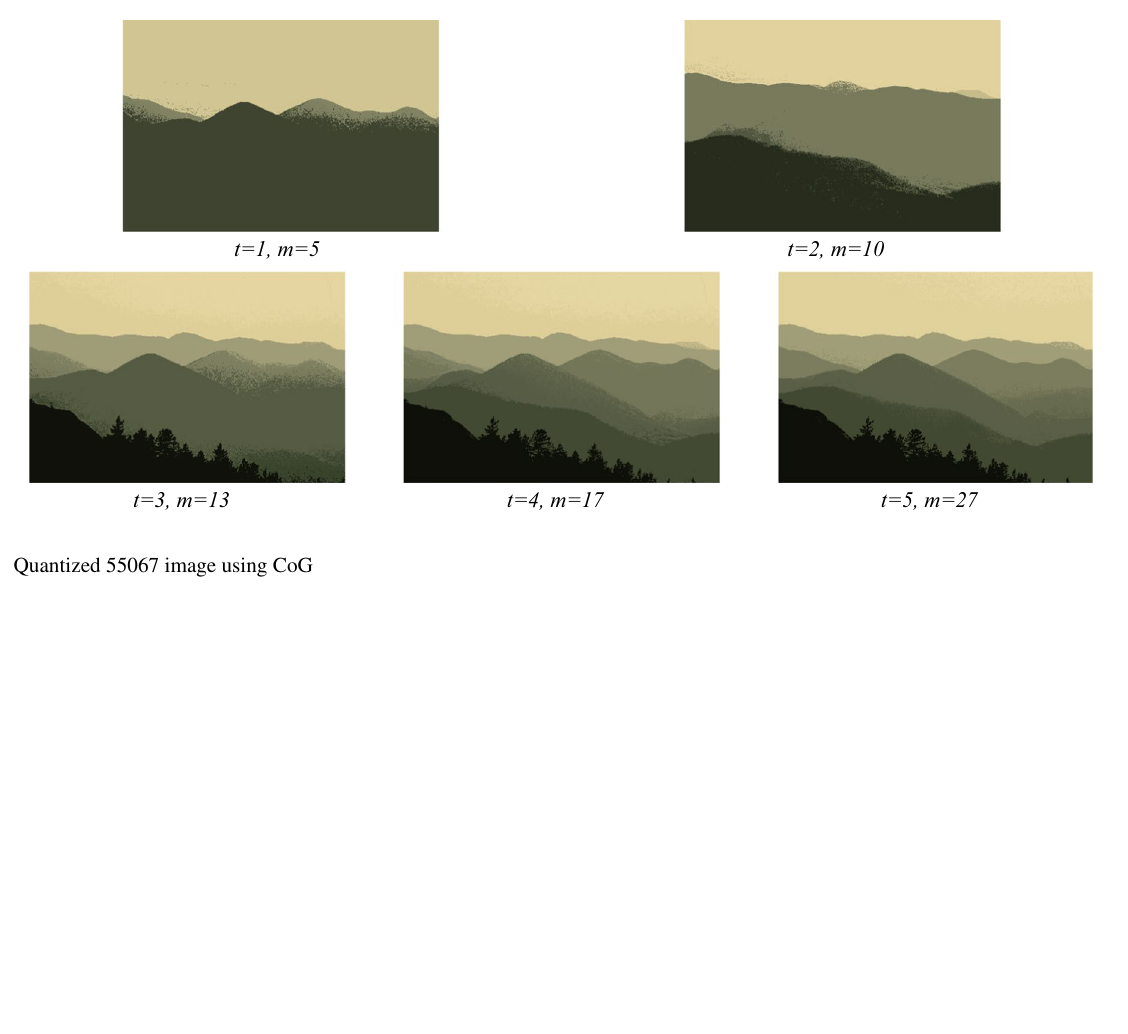
Fig. 14 Quantized 41004 image using CoG